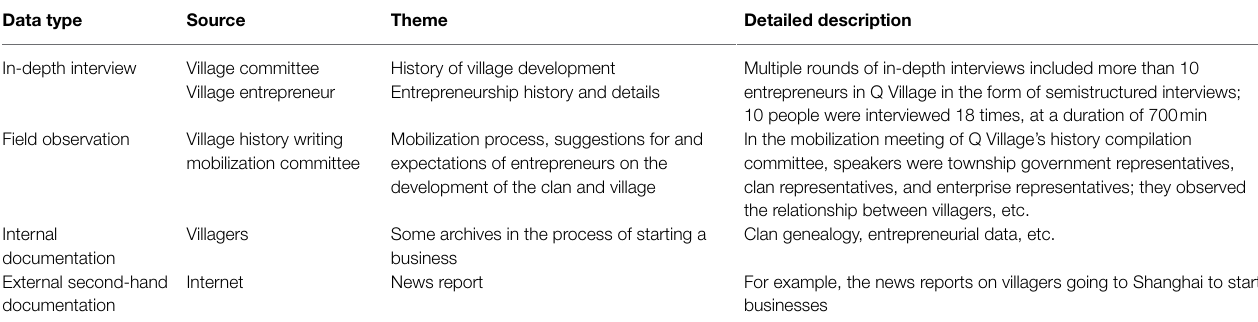
TABLE 1 | Data collection